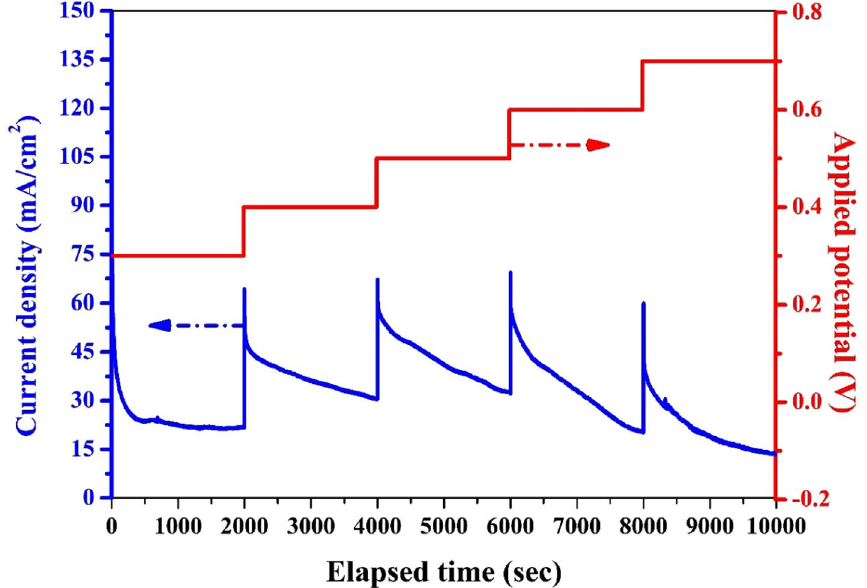
Figure 11. Chronoamperometery analysis at a potential of 0.6 V for the nanofibers obtained from sol–gel having 25 wt%